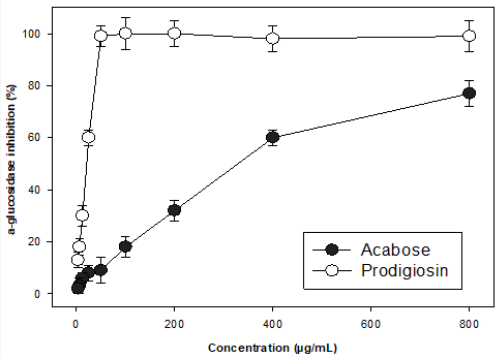
Figure 6. The α-glucosidase inhibitory activities of prodigiosin and acarbose. Figure 6. The α -glucosidase inhibitory activities of prodigiosin and 2.5. Docking study of Prodigiosin towards an Enzyme Targetting Anti-Type 2 Diabetes To understand the interactions of PG (ligand) with the enzyme α-glucosidase (the target protein), a docking study was performed. Acarbose was also used for comparison. The molecular structures of ligands and target protein were prepared using MOE-2015.10 software before docking simulation. Since the in vitro assay of α-glucosidase inhibition was tested at pH 7, a virtual pH of 7 was set to prepare the structures of inhibitors and enzyme molecules. As presented in Figure 7, PG exists in two forms of neutral-PG (Figure 7a), and cation-PG (Figure 7b) in 2.7% and 97.3% proportions, while acarbose exists in neutral form (neutral-AC, Figure 7c), and all three of these ligands were subjected to a docking study with the target enzyme α-glucosidase (Figure 7d). The docking study re- sults are presented in Table 4 and Figure 8. In the docking study, Root Mean Square Deviation (RMSD) was considered an im- portant indicator to define the interactions between ligands (inhibitors) and a binding site on the target protein (enzyme); specifically, it was established whether such binding is acceptable or not. When this value reaches more than 3.0 Å, it indicates the interaction is not significant, and thus, the inhibitor displays a very weak inhibition against the target enzyme based on this binding alternative [26,39]. As shown in Table 4, all three ligands— neutral-PG, cation-PG, and neutral-AC—interacted with binding sites on the target pro- tein with low RMSD values of 1.07, 1.13, and 1.50 Å; they showed good and acceptable interactions by binding to α-glucosidase [26,39]. In the virtual study, to identify potent inhibitors or compare efficacies among inhibitors, docking scores (DS) were used. When an inhibitor interacts with the target enzyme with a DS below −3.2 kcal/mol, it may be a potent inhibitor with good binding ability to the target enzyme [26,40]. According to the results in Table 4, all these ligands (neutral-PG, cation-PG, and neutral-AC) were potent inhibitors due to their very low DS values of −9.5, −14.6, and −10.5 kcal/mol, respectively. Of these, the neutral-PG showed a slightly lesser inhibitory effect than the neutral-AC, but the cation form of PG (cation-PG) was a much stronger inhibitor than acarbose based on their DS values. In addition, the cation-PG is recognized as the major form of PG at 97.3% based on the output from the MOE-2015.10 software. This virtual result is in agreement with the experimental in vitro tests (Figure 6).